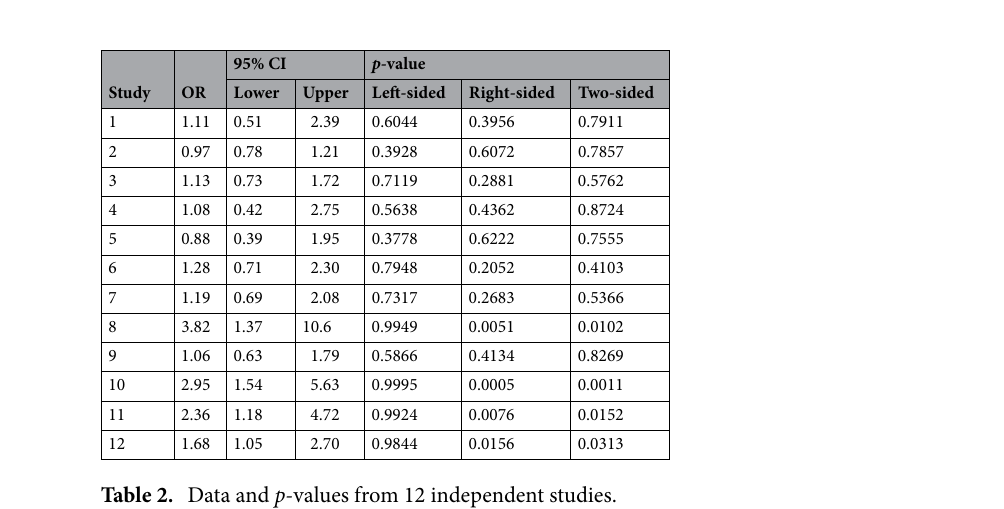
Table 2. Data and p -values from 12 independent studies.